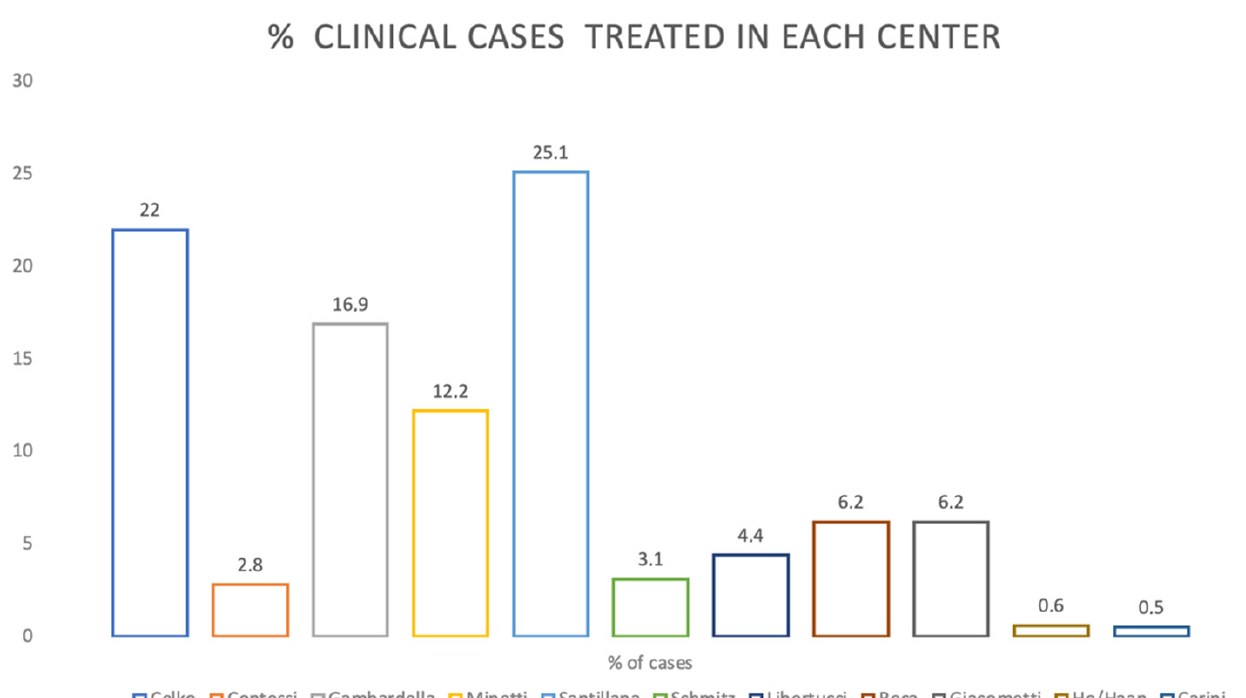
Figure 3. Percentage of cases in each center.